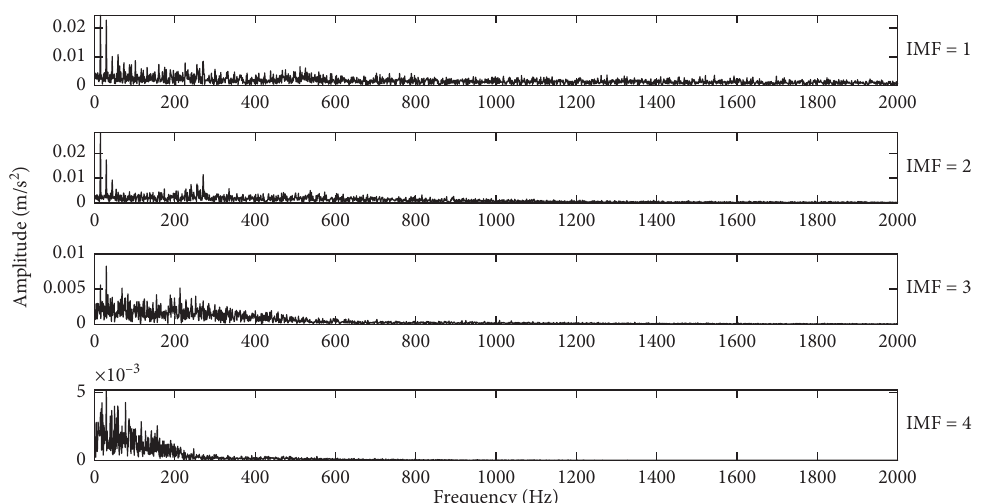
Figure 21: Frequency spectrums of IMFs after EMD.